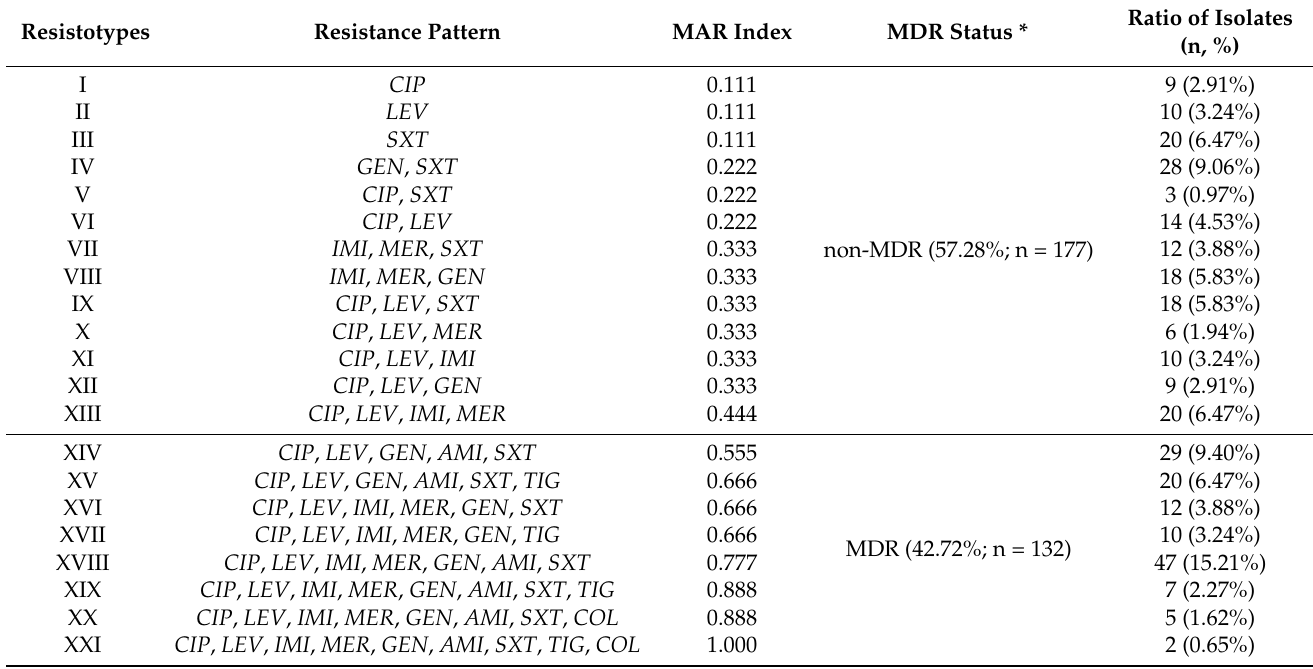
Table 1. Resistotype distribution and MAR indices of respective